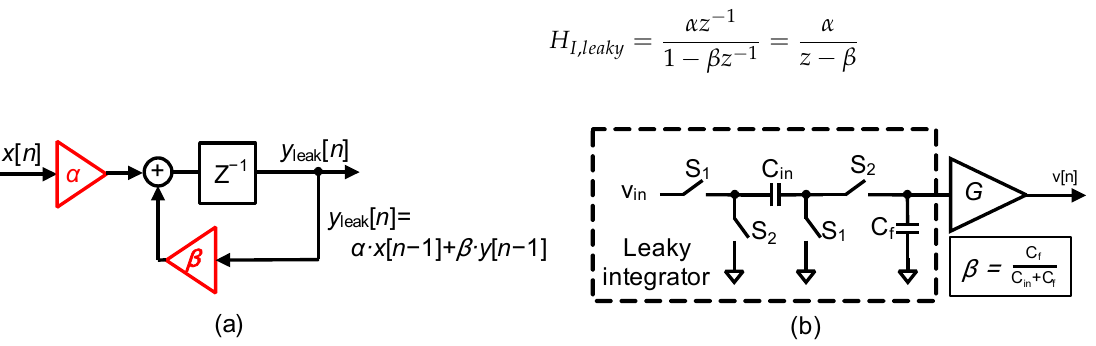
Figure 2. ( a ) A block diagram of the leaky integrator and ( b ) an implementation of the leaky integrator with a gain element. Figure 3 redraws the IDSM model, where a leaky integrator is used for the 1st stage. We